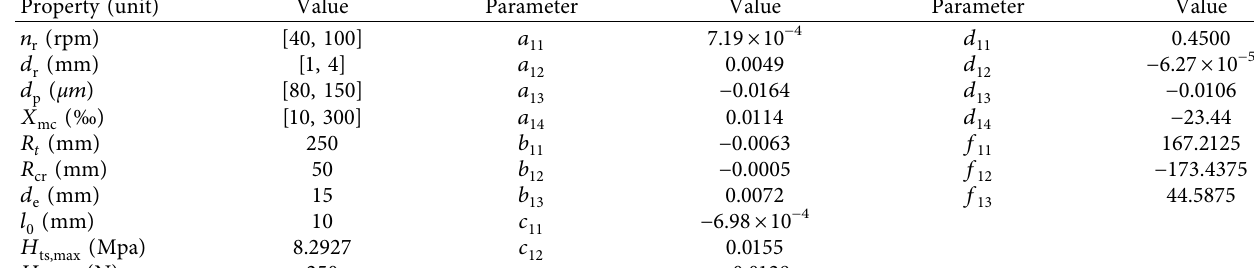
Table 2: The simulation experimental conditions for tabletting.